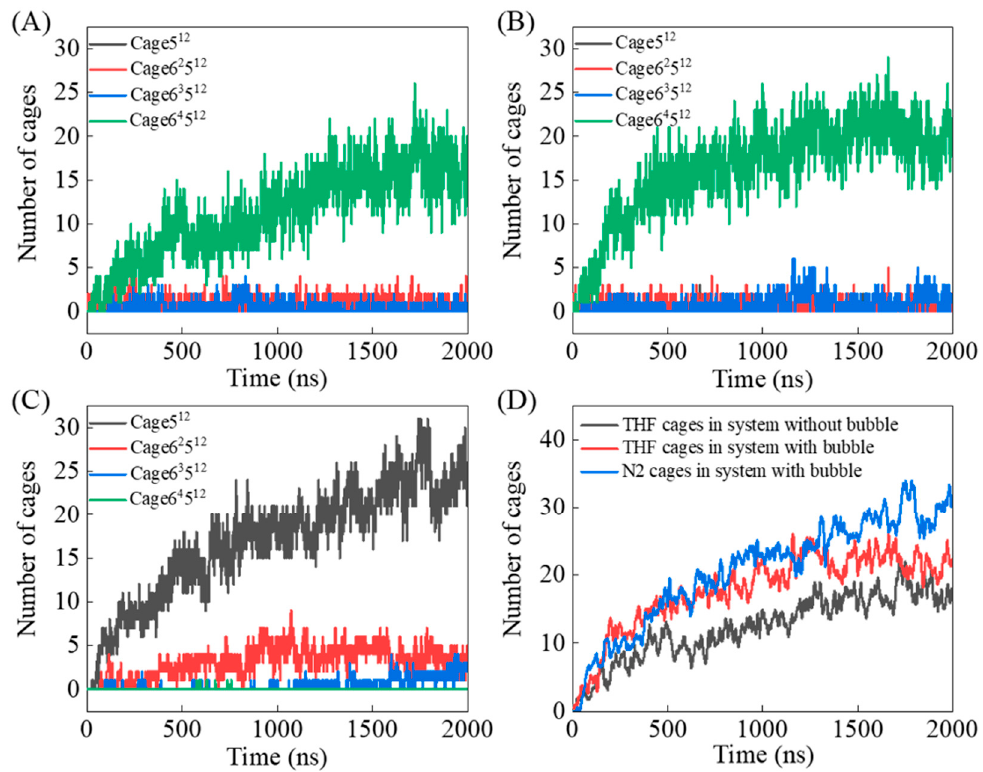
Figure 4. Time evolution of the number of ( A ) THF-filled cages in system without a nitrogen bubble, ( B ) THF-filled cages and ( C ) nitrogen cages in system with a nitrogen bubble, and the total THF-filled cages and nitrogen cages in each system. ( D ) Comparison of cage numbers for systems with or without a nitrogen bubble.